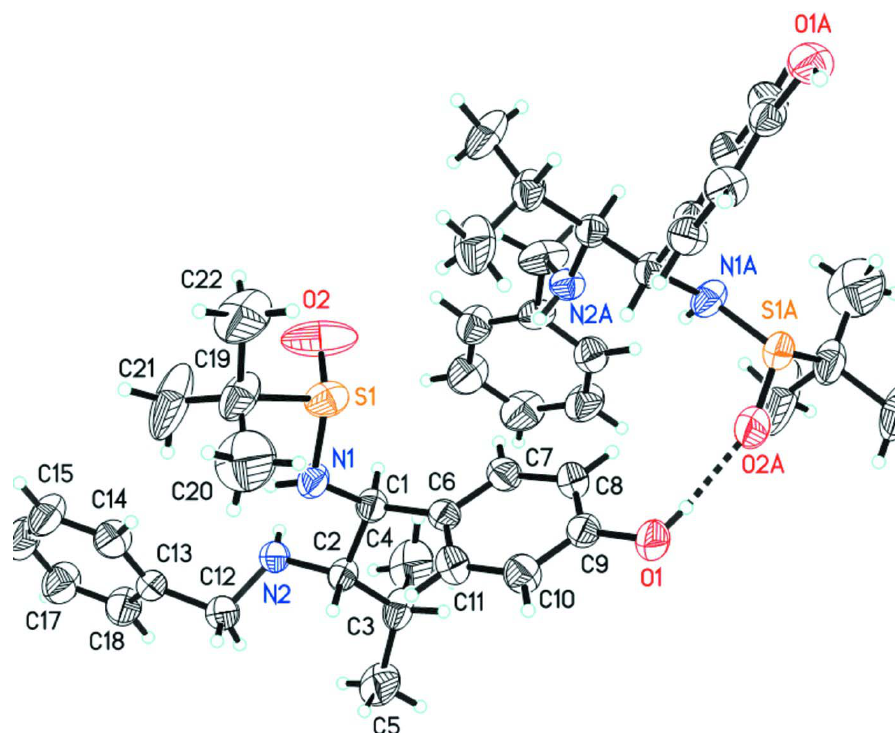
Figure 2 Hydrogen bonding in the title compound. Symmetry codes: (i) - x + 1, y + 1/2, - z +